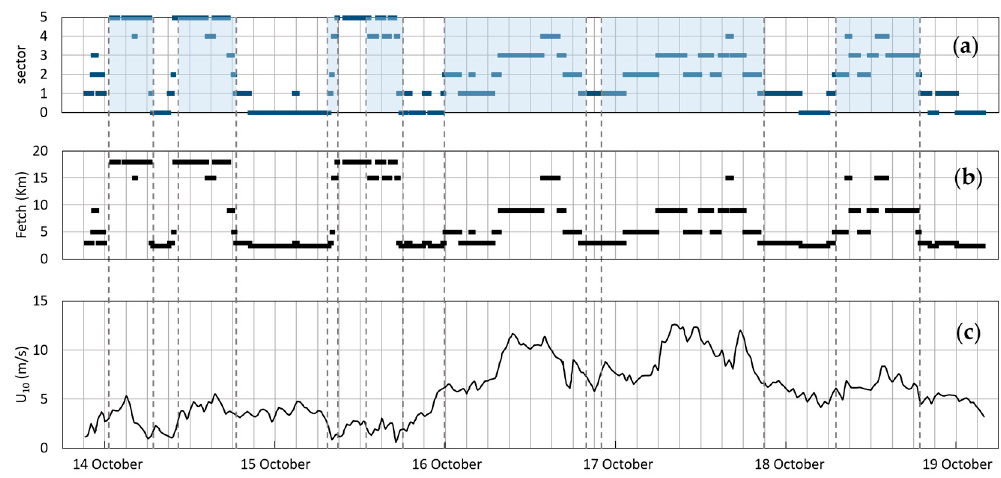
Figure 7. Wind data measured during the campaign of October 2005 [53]: ( a ) sectors of blowing winds; ( b ) the relative mean fetch according to the values in Table 3; ( c ) the wind speeds. The colored bands limited by the dashed lines correspond to the conditions of fully developed wave motion which satisfy relation (10).